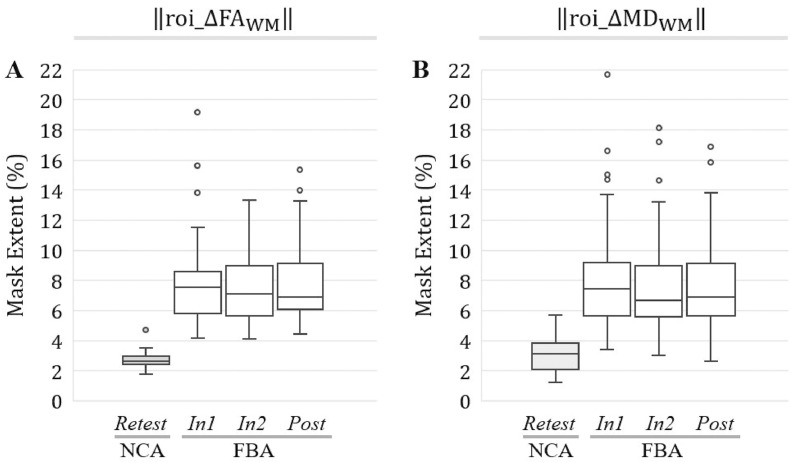
At all follow-up sessions, football athletes (FBA) exhibited significantly (p < 0.001) greater spatial extents of substantial changes in FA and MD, in ROIWM, than did noncollision athletes (NCA). Box-and-whisker plots are presented at each follow-up session for (A) ‖roi_ΔFAWM,j,i‖; (B) ‖roi_ΔMDWM, j,i‖.